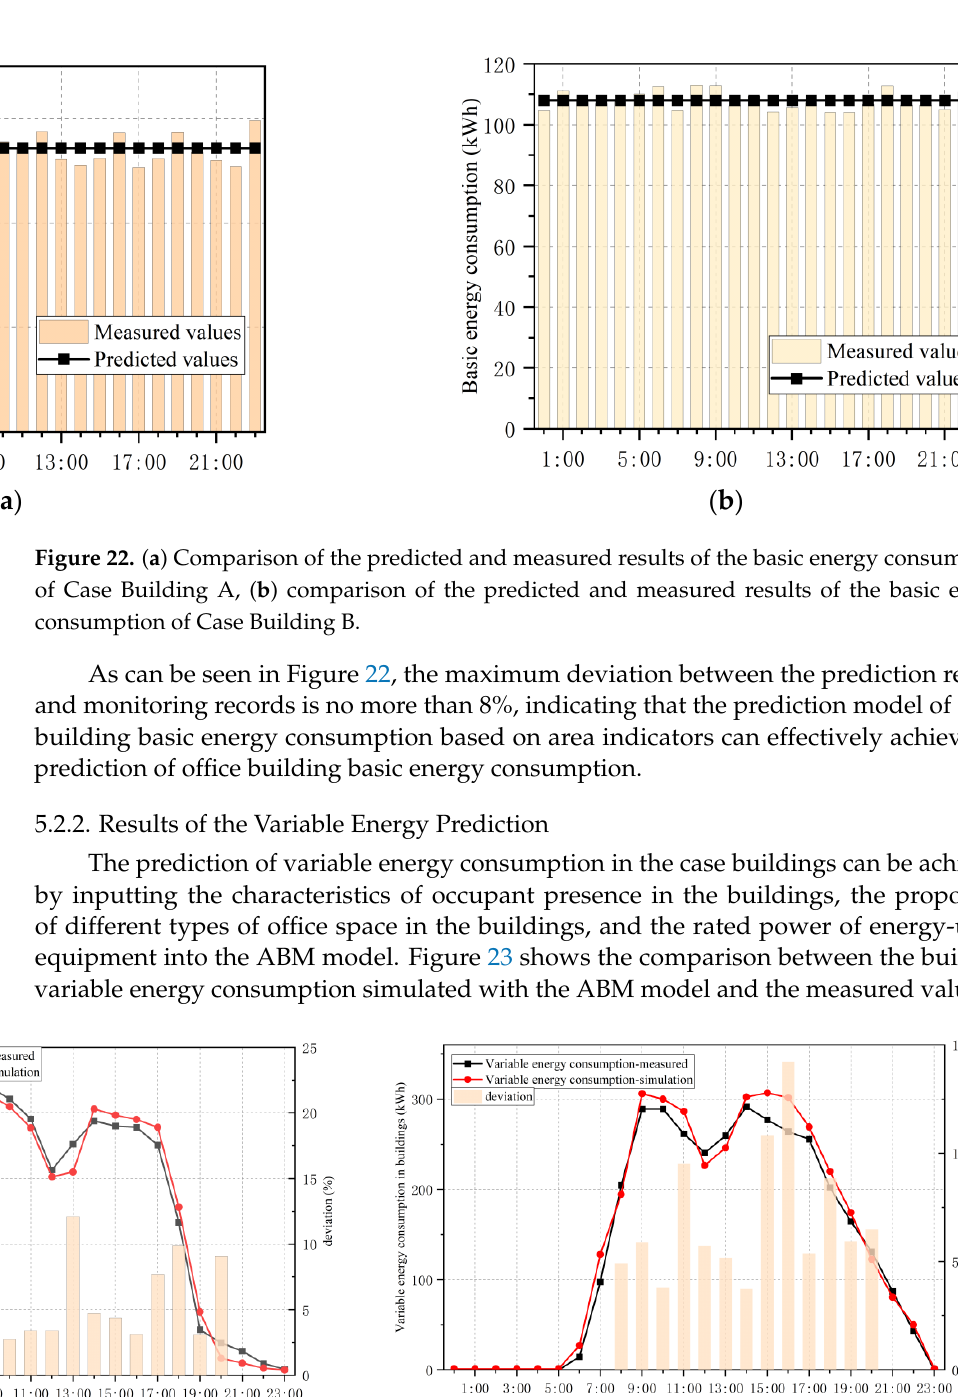
Case Building A, ( b ) comparison of simulated and measured values of variable energy consumption in Case Building B.